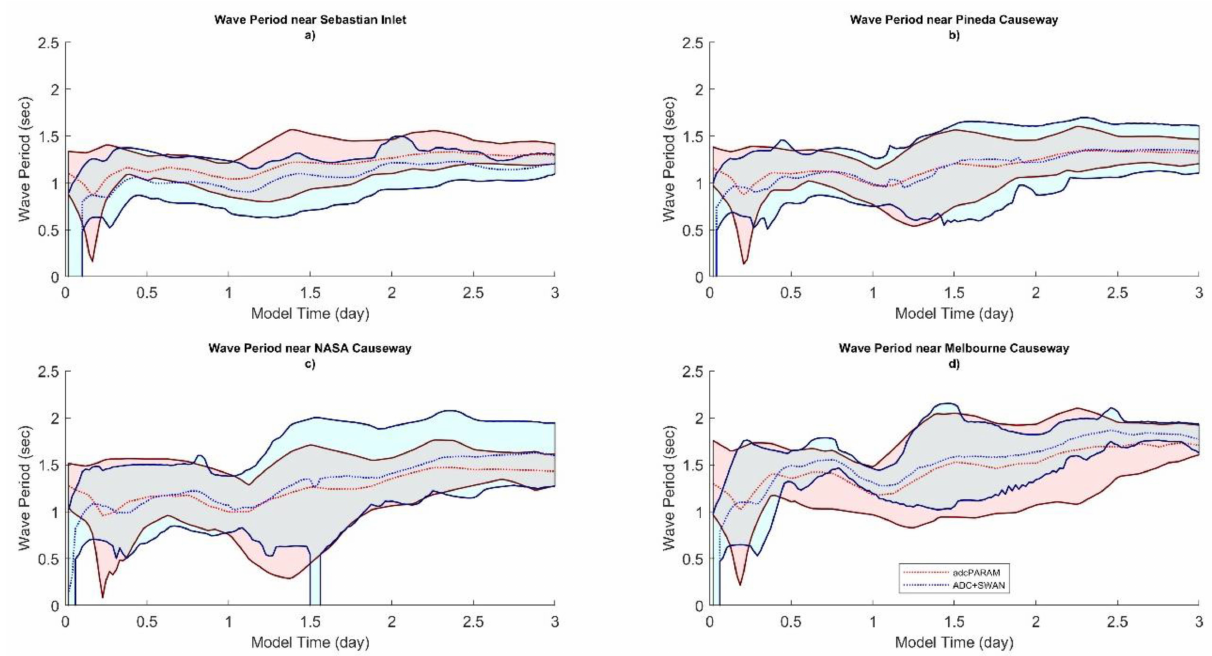
Figure 14. Time series plots of ADCparam and ADCIRC + SWAN ensemble ranges for wave period (seconds) near ( a ) Sebastian Inlet, ( b ) Pineda Causeway, ( c ) NASA Causeway, and ( d ) Melbourne Causeway. Each of these locations was selected based on location in the domain and associated fetch (station coordinates specified in Figure 8). Dotted lines represent the average solution across the full ensemble, while upper and lower bounds of shaded areas represent the maximum and minimum values of the whole